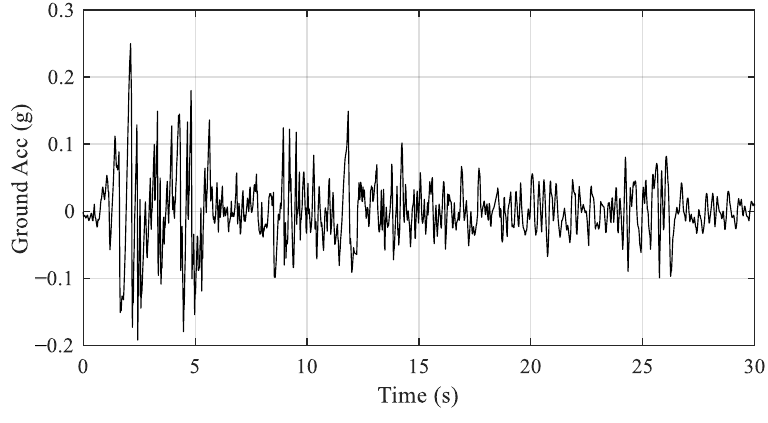
Figure 2. Determination of N w using optimization and single degree of freedom (SDOF).